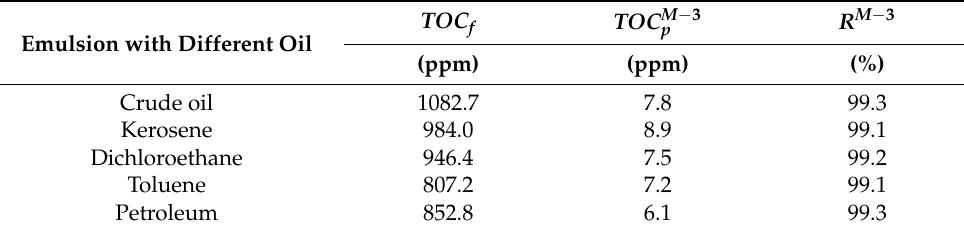
Table 3. The TOC results for emulsions before and after